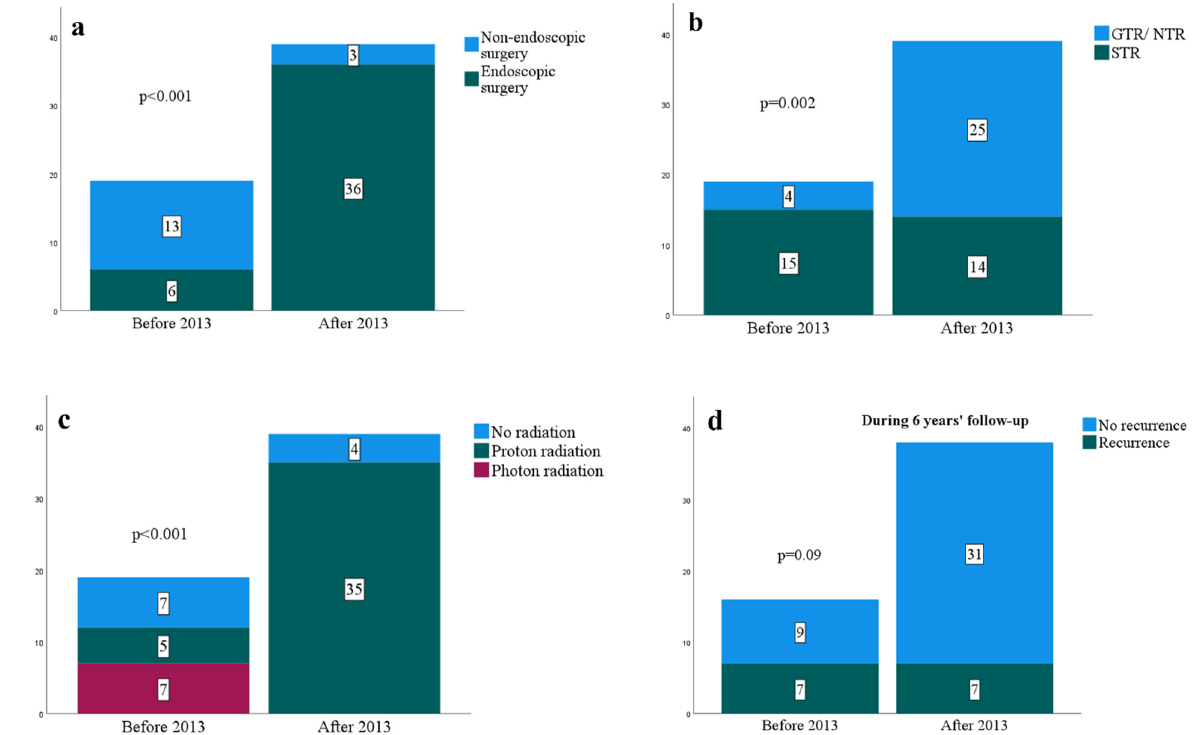
Figure 1. Chart bars comparing various factors before 2013 and after 2013. ( a ) Endoscopic surgeries; ( b ) Resection degree; ( c ) Adjuvant radiation status ( d ) Recurrences in the first six years. Table 2. The operative approach and the degree of resection based on the clival chordoma loca ‐ tion.